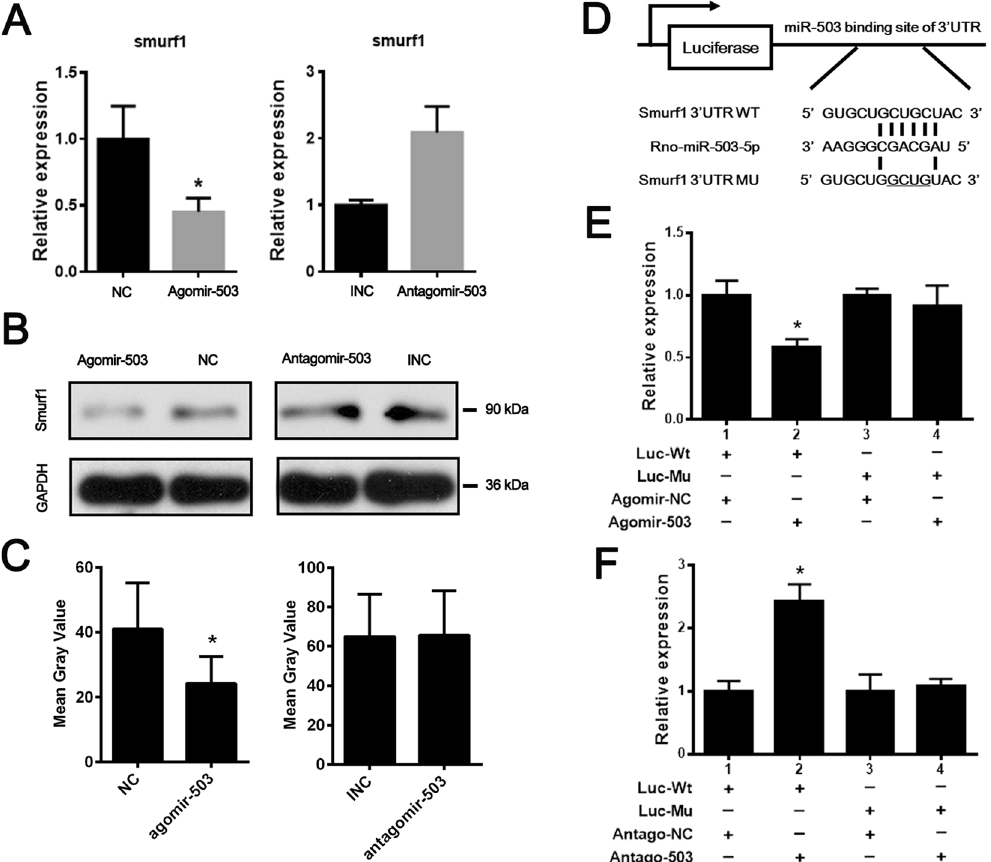
Figure 3. MiR-503 directly targets Smurf1. ( A ) Smurf1 expression was significantly decreased by agomir-503 at mRNA level. (n = 3, * P < 0.05). ( B ) Smurf1 protein expression was decreased by agomir-503 transfection while increased by antagomir-503 at protein level. ( C ) The result of western blot bends was quantified by the mean gray value. Significant difference in gray value could be found after agomir-503 transfected, compared to the NC group. However, no difference could be found after antagomir-503 transfected. ( D ) Schematic diagrams of the luciferase reporter construction. Wild type (Wt) and mutant (Mu) 3 ′ UTR of Smurf1 containing the binding site with miR-503 were inserted into pMIR-GLO vector. ( E,F ) HEK293 cells were transfected with miRNA oligoes combined with luciferase reporter (Wt). The effect of miR-503 on the luciferase activity was measured by luciferase reporter assays. MiR-503 could suppress while its inhibitor promote the luciferase activity. On the other hand, the miR-503 binding sites were mutated and the mutated luciferase reporters were co-transfected with agomir-503 or antagomir-503. The mutations on binding sites abolished the previously suppressive or promoted effects. (n = 3 each group, * P <